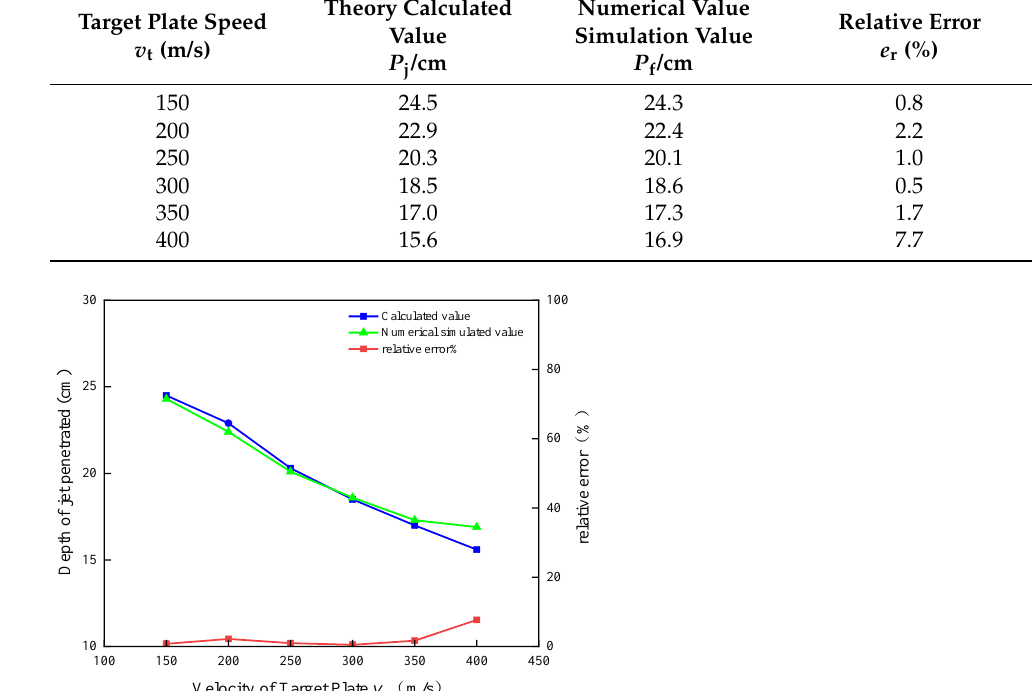
Table 3. Comparison of jet penetration depth between theoretical calculations and numerical simulations.